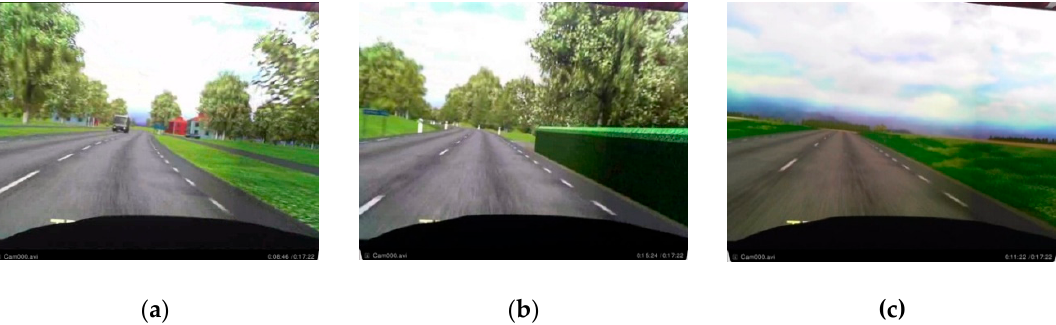
Figure 2. Three of the study scenarios, ( a ): Car approaching the crossing from the right (CR); ( b ): Hidden exit on the right side of the road with a warning sign (HE); and ( c ): Strong side wind in open terrain (SW) scenario.